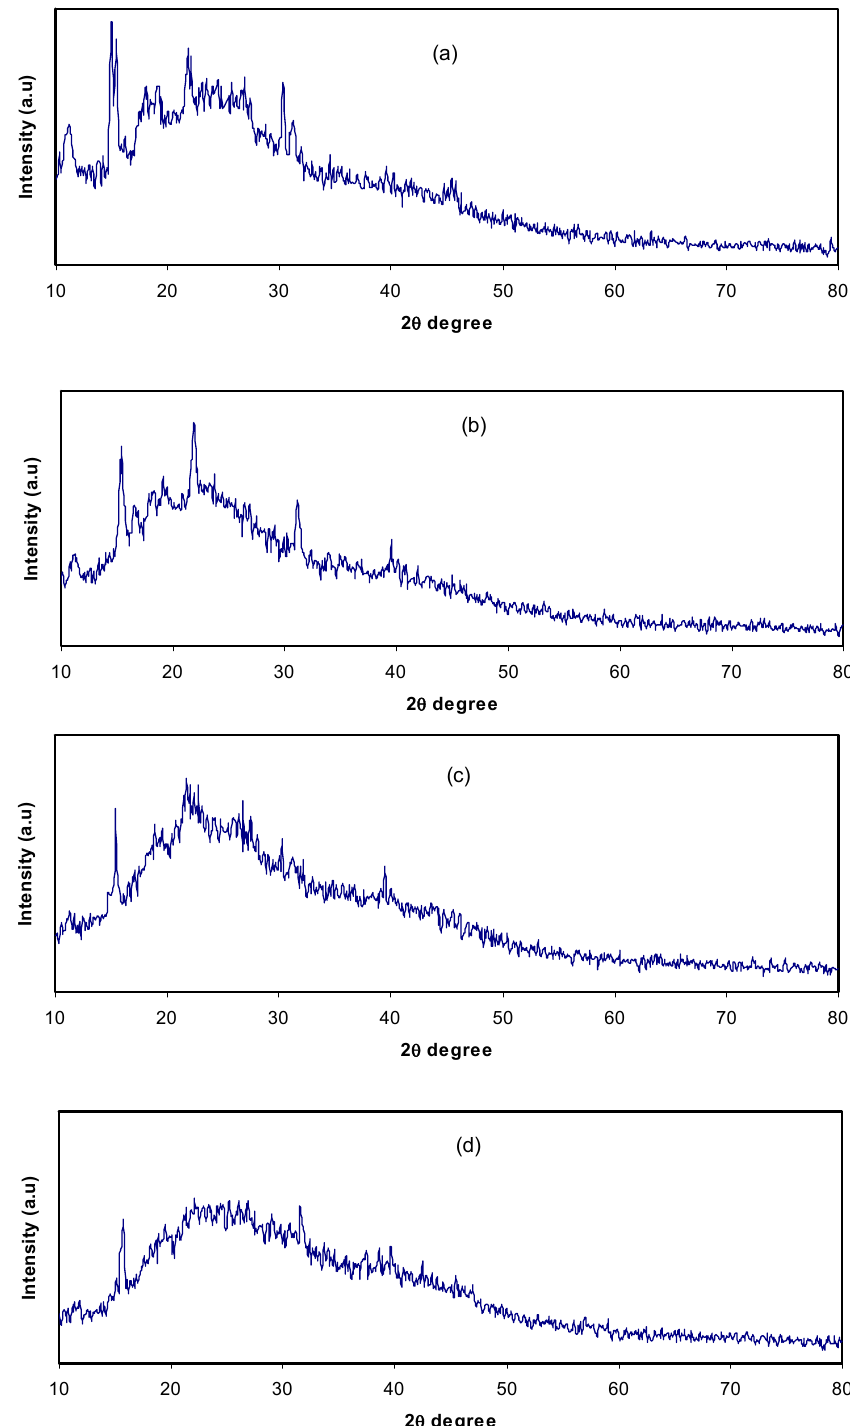
Figure 1. XRD patterns for ( a ) CSNHG0, ( b ) CSNHG2, ( c ) CSNHG4 and ( d ) CSNHG5.